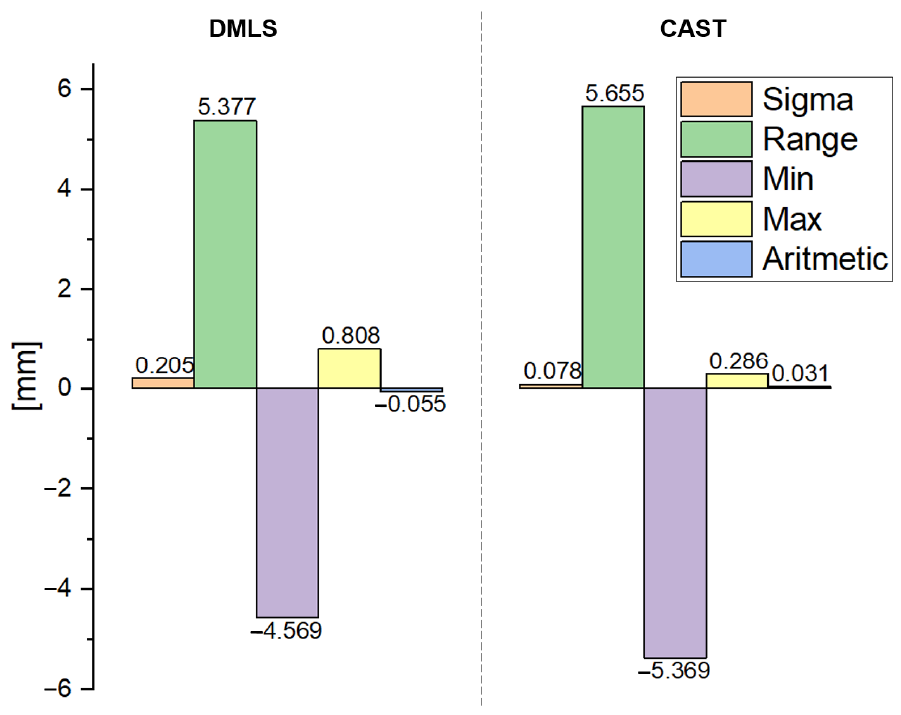
Figure 4. Statistical data generated in the Gom Inspect software for the DMLS and as-cast samples. Many parameters of the 3D printing process determine the AM product topography.